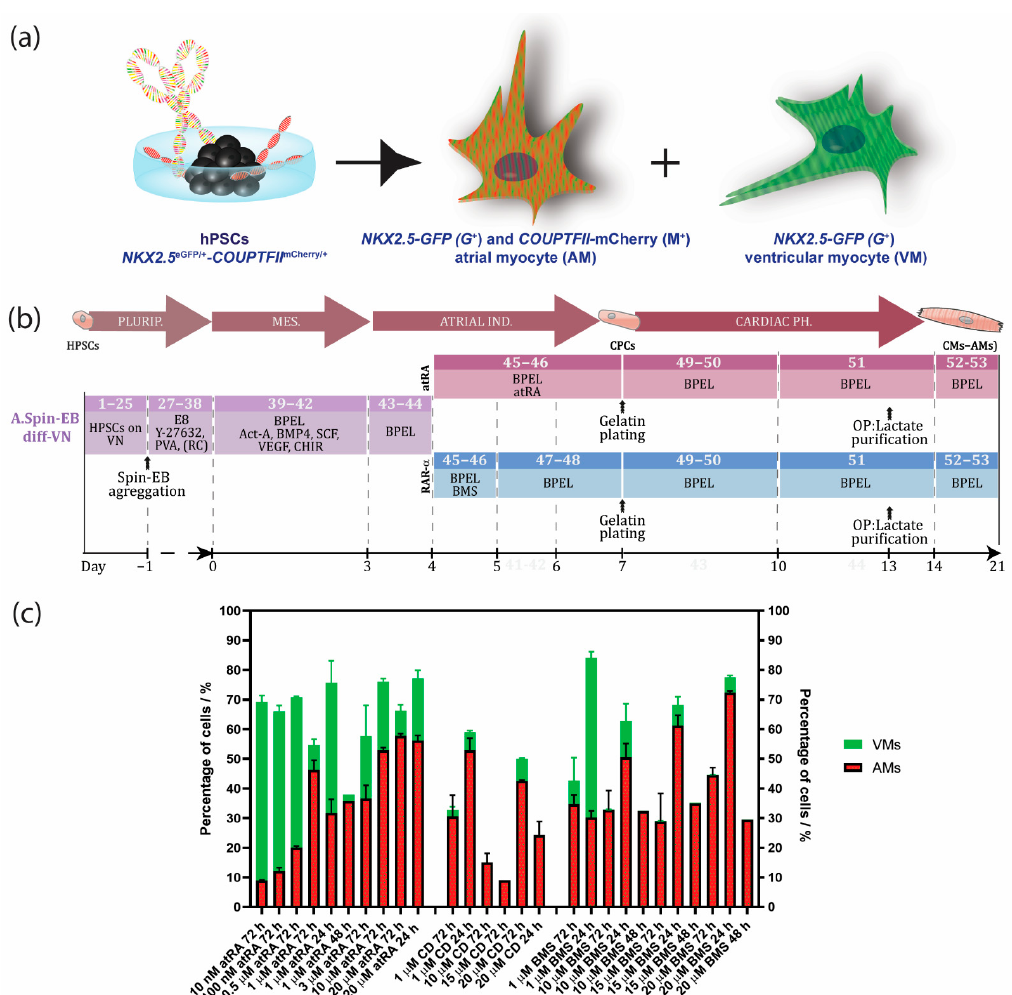
Figure 1. Timeline with overview of hPSC-derived atrial differentiation protocols and NKX2.5 eGFP/+ - COUP-TFII mCherry/+ fluorescent reporter hPSC line for selection of atrial (AMs) and ventricular cardi- omyocytes (VMs). ( a ) Visualization of the NKX2.5 eGFP/+ -COUP-TFII mCherry/+ . AMs can be selected by NKX2.5-GFP (G + ) and COUP-TFII-mCherry (M + ) expression, whereas VMs can be purified by NKX2.5-GFP (G + ) expression and the absence of COUP-TFII-mCherry (M − ). ( b ) Spin EB protocol with RA or RAR α induction from hPSCs cultured in defined culture conditions with E8 medium on vitronectin. Numbers in each section indicate the step corresponding to the step-by-step protocol of Supplementary Materials. ( c ) Optimization of the atrial differentiation protocol by activation of all- trans retinoic acid (atRA), retinoic acid receptor alpha (RAR α ) with BMS-753 (BMS), or RAR β with CD-2314 (CD) using the NKX2.5 eGFP/+ -COUP-TFII mCherry/+ line for quantifying the percentage of AMs or VMs. Data shown as means ± S.E.M. Plurip. = pluripotency; MES. = mesoderm; Ind. = induction; Ph. = phenotype; CPCs = cardiac progenitor cells; CMs (AMs) = atrial cardiomyocytes; VN = vitron- ectin; Diff = differentiation; Act-A = activin-A; RC = RevitaCell; OP = optional.